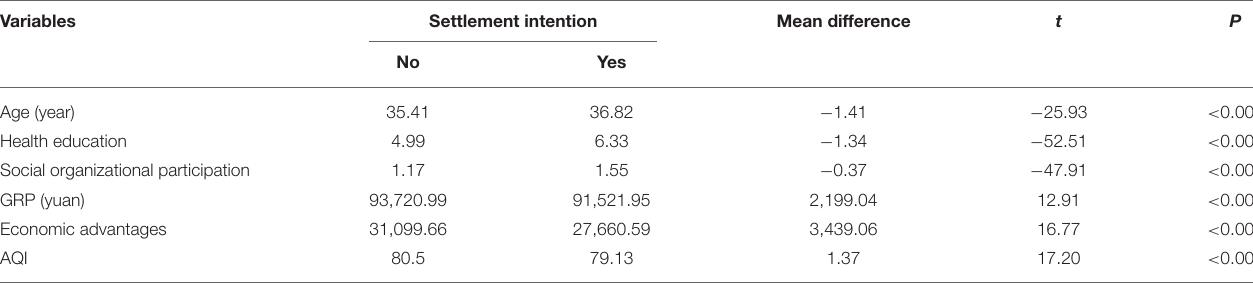
TABLE 3 | The relationship between characteristics of migrants and settlement intention.